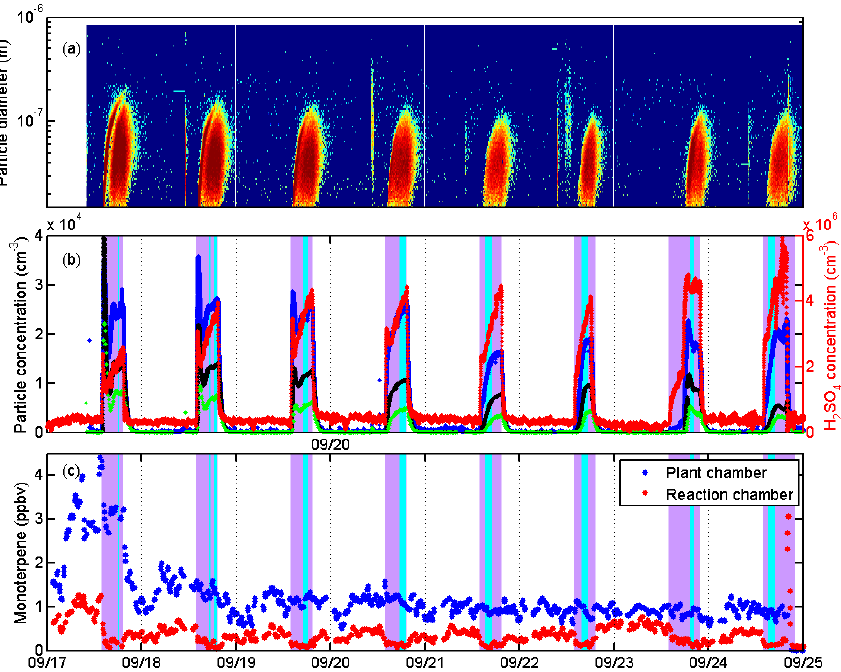
Figure 2. (a) Contour plots of aerosol particle number size distributions as function of time measured by SMPS. (b) Time series of total particle number concentrations (blue: PSM concentration, black: CPC concentration, green: SMPS concentration) and sulfuric acid concen- trations (red), and (c) time series of monoterpene concentrations measured by PTR-MS during the chamber experiments for both chambers. The purple bars indicate the UV-on periods and the cyan bars illustrate the selected periods of steady state for calculating nanoCN formation rates (see Sect. 2.4). On 23 September, the event starting later is due to late ozone addition.